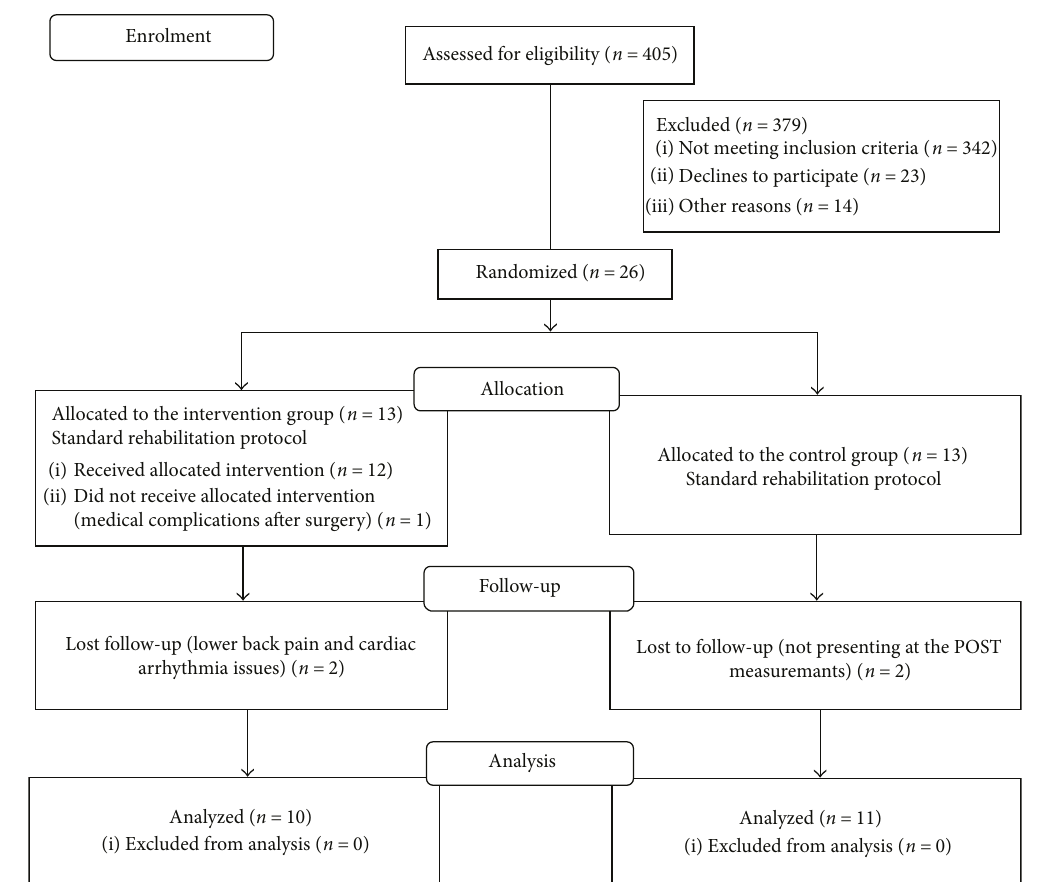
Figure 1: CONSORT fl ow diagram of the PANGeA hip study, Valdoltra 2015